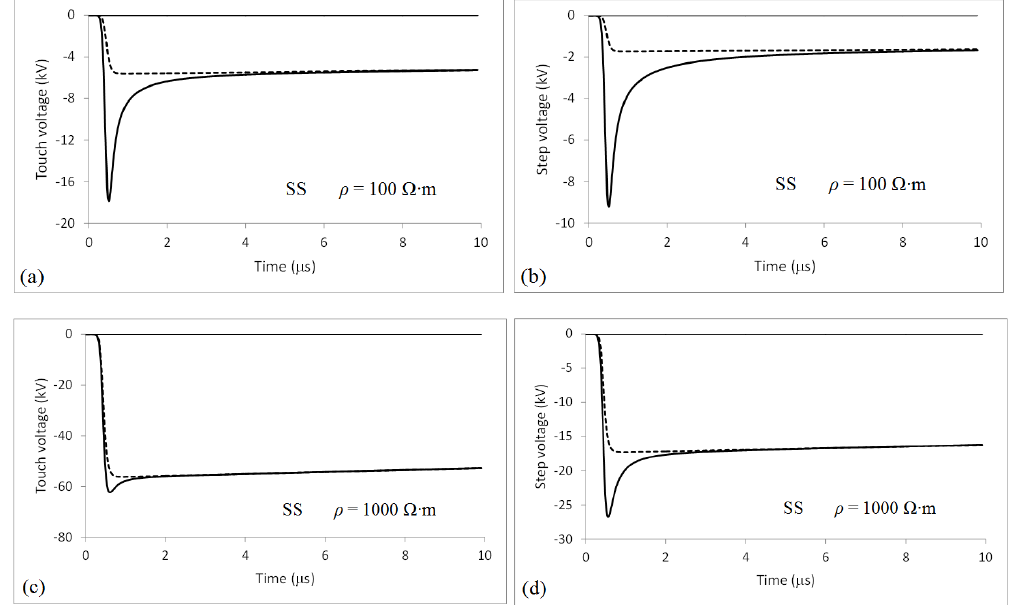
Figure 8 . Touch voltage (TV) and step voltage (SV) for subsequent stroke (SS). Solid line: transient Figure 8. Touch voltage (TV) and step voltage (SV) for subsequent stroke (SS). Solid line: transient response calculated from Equation (4); Dashed line: DC response calculated from Equation (13). response calculated from Equation (4); Dashed line: DC response calculated from Equation (13). ( a ) TV and ρ = 100 Ω · m; ( b ) SV and ρ = 100 Ω · m; ( c ) TV and ρ = 1000 Ω · m; ( d ) SV and ρ = 1000 Ω ·